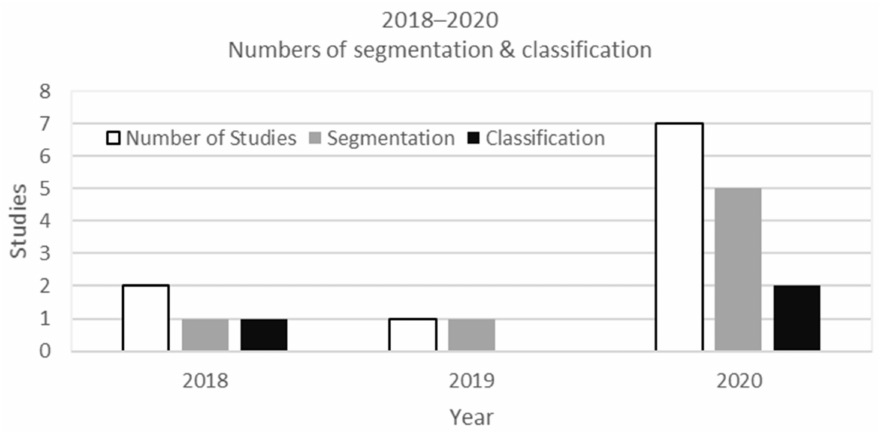
Figure 3. The development of deep learning studies for muscle ultrasound images from 2018 to 2020.